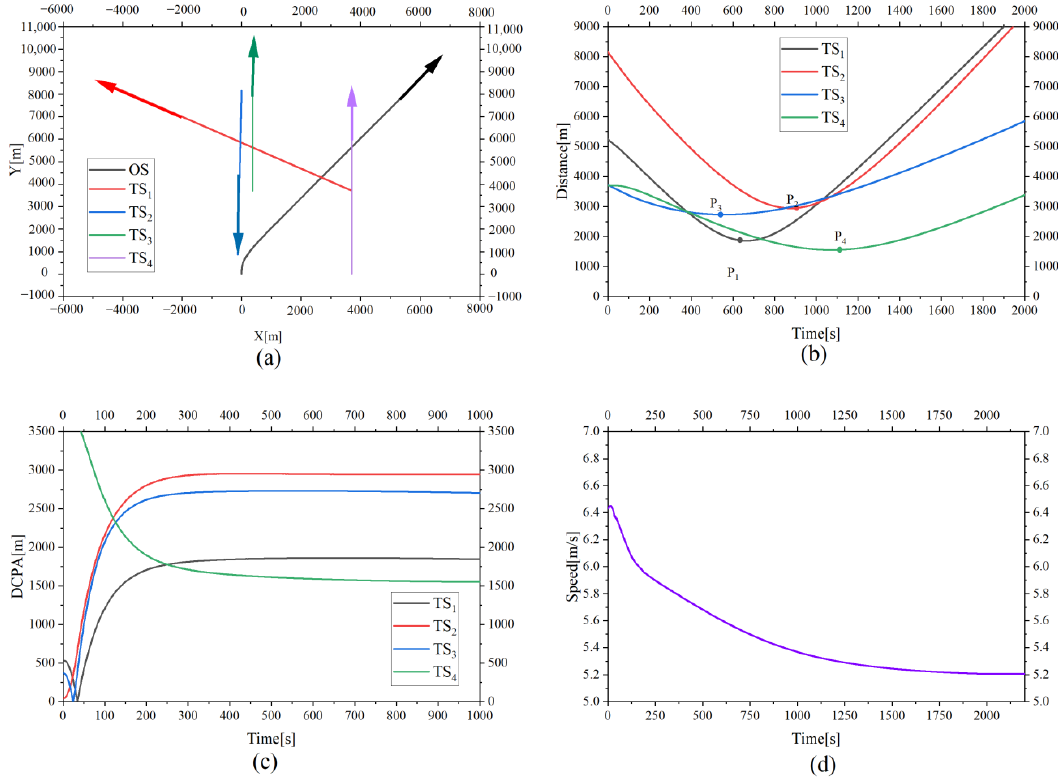
Figure 12. Dynamic feasible manoeuvring interval of scenario 1.